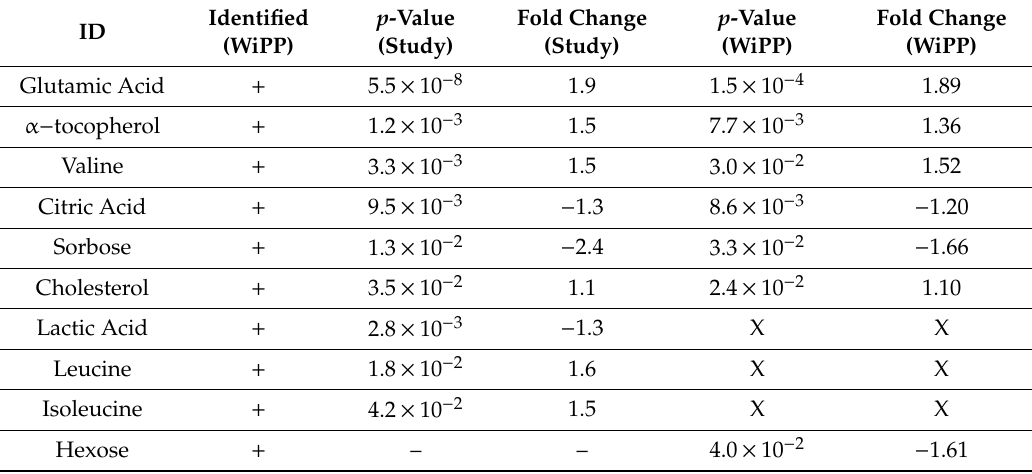
Table 1. Comparison of the results found by the published study to the one produced using WiPP automated workflow. (X) Data could not be automatically computed. (–) Missing